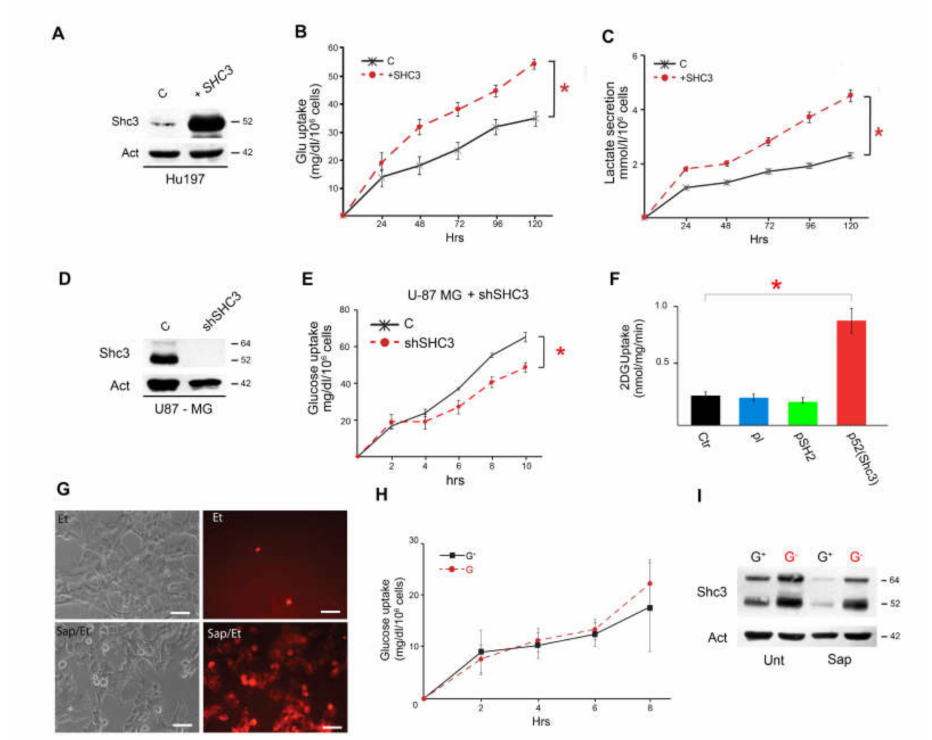
Figure 2. Increased SHC3 levels enhanced glucose consumption, lactate secretion and a ff ected vesicle recycling. ( A ) Western blot using protein lysates from Hu197 after transfection with a control plasmid ( C ) or a plasmid encoding for p52SHC3 cDNA. ( B ) Rates of glucose uptake by Hu197 cells (black X) and by the same cells after transfection with cDNA encoding for p52SHC3 (red dots). Uptake of glucose in cells overexpressing SHC3 cDNA is significantly increased. Data are means ± SD (at least n = 3 experiments, *: P < 0.05). ( C ) Rates of lactate secretion in the medium by Hu197 cells (black X) and by the same cells after transfection with cDNA encoding for p52SHC3 (red dots). Release of lactate in cells overexpressing SHC3 cDNA is significantly increased. Data are means ± SD (at least n = 3 experiments, *: P < 0.05). ( D ) Western blot analysis using protein lysates from U-87 MG after transfection of a control plasmid or a plasmid encoding a shRNA targeting SHC3 mRNA. ( E ) Time course of glucose consumption by U-87 MG 76 h after transfection with control (black) or shRNA targeting SHC3 mRNA (red): shRNA transfection decreases significantly glucose uptake. ( F ) Rates of 3 H-2DG uptake in Hu197 cells (Ctr) and after transfection of an empty plasmid (pl), or the same plasmid encoding for the SH2 domain of SHC3 (pSH2), or the same plasmid encoding for the entire p52SHC3. 3 H-2DG uptake is enhanced only after p52SHC3 transfection. ( G ) Dark-field and fluorescent pictures of U-87 MG cells with and without membrane permeabilization with saponin. Red fluorescence results from the addition of ethidium bromide (EtBr), a membrane impermeant dye, whose presence inside the cells indicates membrane permeabilization. The cells that fluoresce in the absence of saponin (Ctr) are dying cells. Scale bar 10 mm. ( H ) Rates of glucose uptake in the presence of saponin. Before the addition of fresh medium containing saponin U-87 MG cells were maintained as shown in Figure 1D. Saponin cancelled the di ff erence in glucose uptake between cells maintained with (G + ) or without (G − ) daily replacement of glucose. ( I ) Western blot analysis using protein lysates from U-87 MG growing according to Figure 1D without (Unt) or with Saponin treatment (Sap). The presence of saponin does not a ff ect the increase in SHC3 levels induced by glucose deprivation (G −